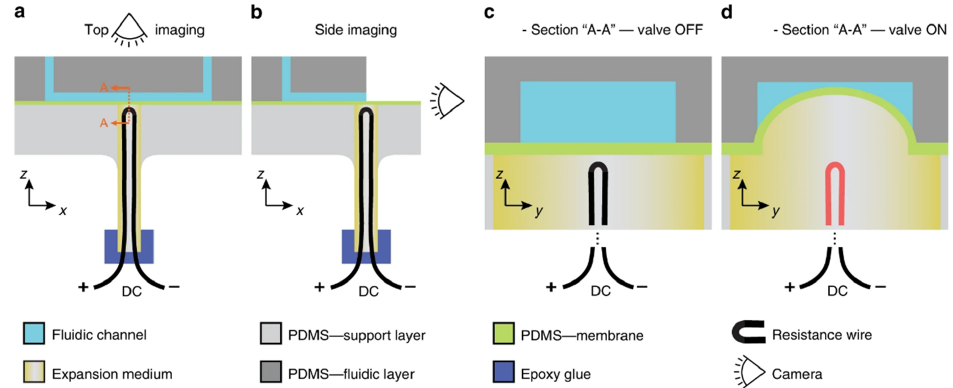
Figure 14. ( a ) The three-layer PDMS setup has a fluidic layer that houses the fluidic access ports and microchannels on the top. The middle layer houses the PDMS membrane that is ~200 µ m thick; the bottom layer has a punched-hole with a glass capillary fitted. The capillary is filled with the expansion medium, and a resistance wire is inserted for heating. The capillary is sealed with epoxy glue. Imaging is from the top as shown. ( b ) The side imaging option is shown. During side imaging, the fluidic layer is cut in the middle for visualizing membrane deformation in real time. ( c ) Zoomed in A-A section view where the valve is in the OFF-state, no heating. ( d ) Zoomed in A-A section view where the valve is in the ON-state. Thermal expansion of the medium causes the membrane to block the flow in the fluidic layer. Permission granted by the publisher